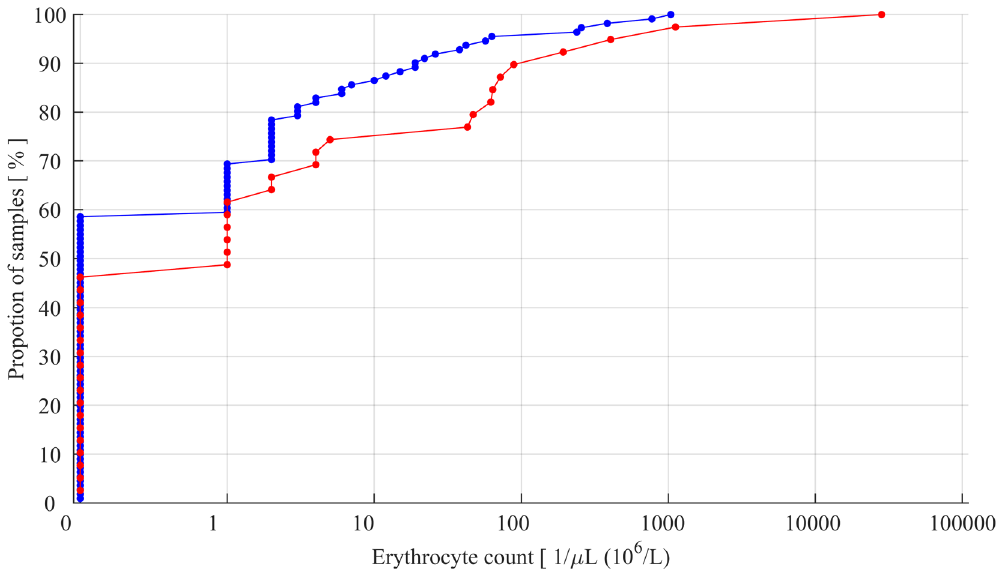
Figure 2. Cumulative distribution curves of erythrocyte count data obtained from the study LP procedures when the performance of the bioimpedance needle system was correct (blue line) or there was false or missed detections (red